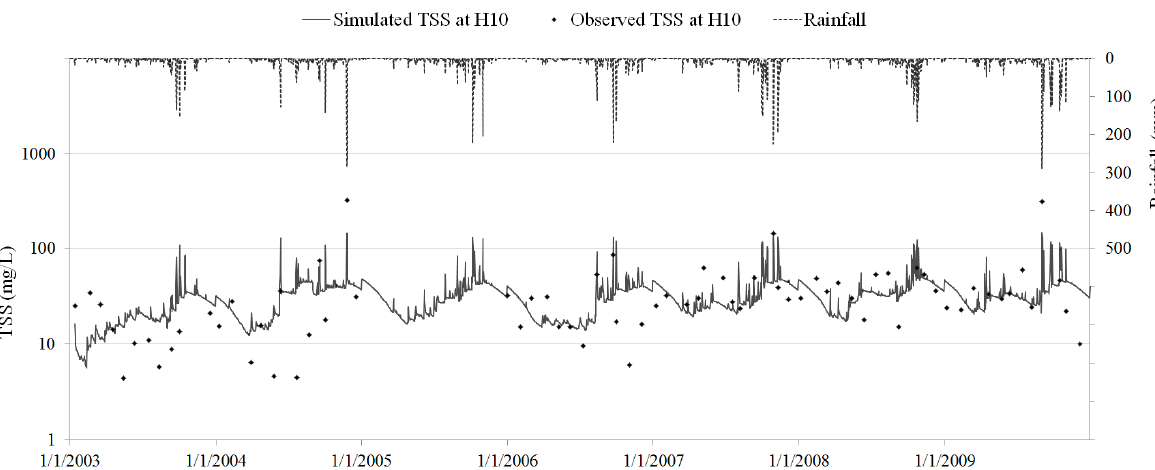
Figure 11. TSS validation at